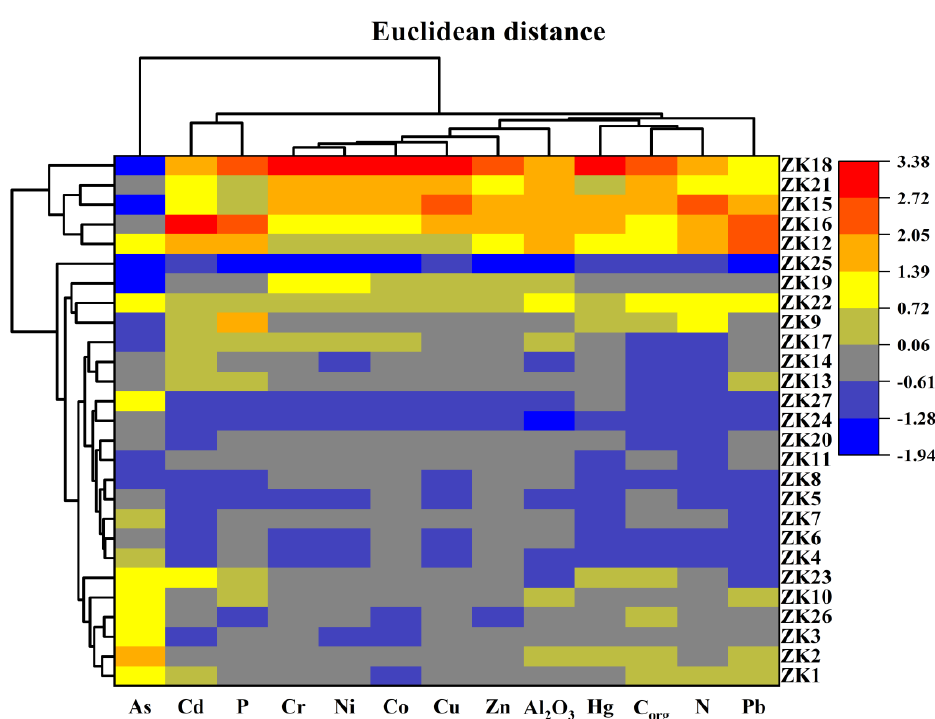
Figure 6. The overall heat map of the physico − chemical properties and heavy metals concentrations in the wetland sediment, showing their significant variations and interactions among the variables. Shade represents the mean concentration after normalization. The left tree diagram represents the clustering of points. The upper tree diagram represents the clustering of elements with correlation.